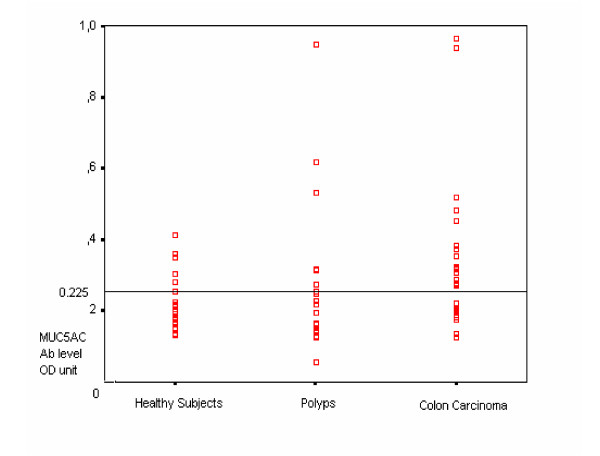
Incidence of circulating MUC5AC antibody in sera of healthy subjects, polyps, and colorectal carcinoma. As an arbitrary cut-off level 0,225 OD units was chosen. OD: Optical density.